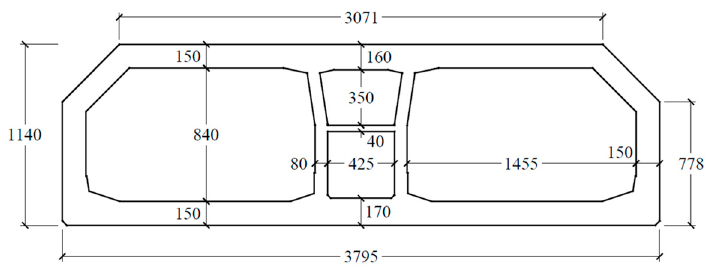
Figure 13. Cross-sectional geometry of the HZMB immersed tunnel (unit: cm).